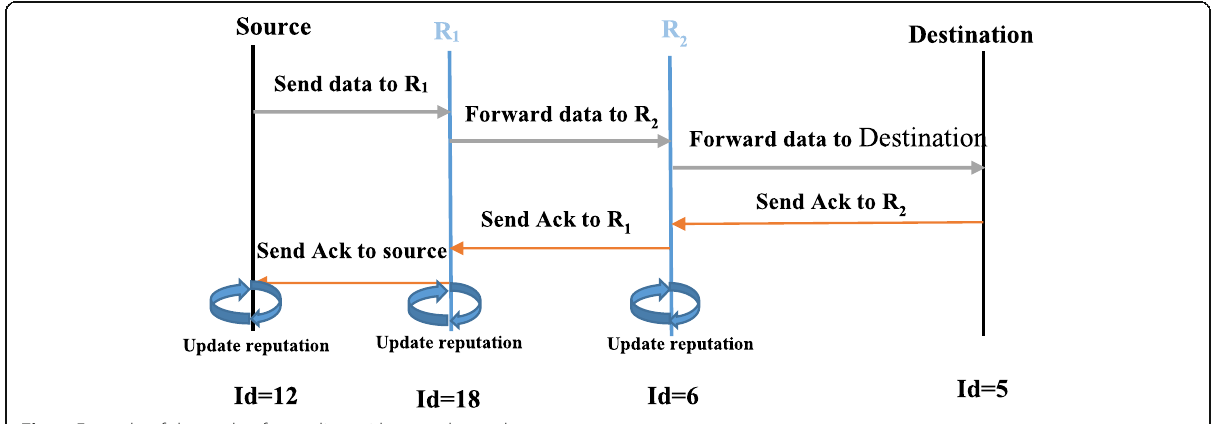
Fig. 5 Example of the packet forwarding with two relay